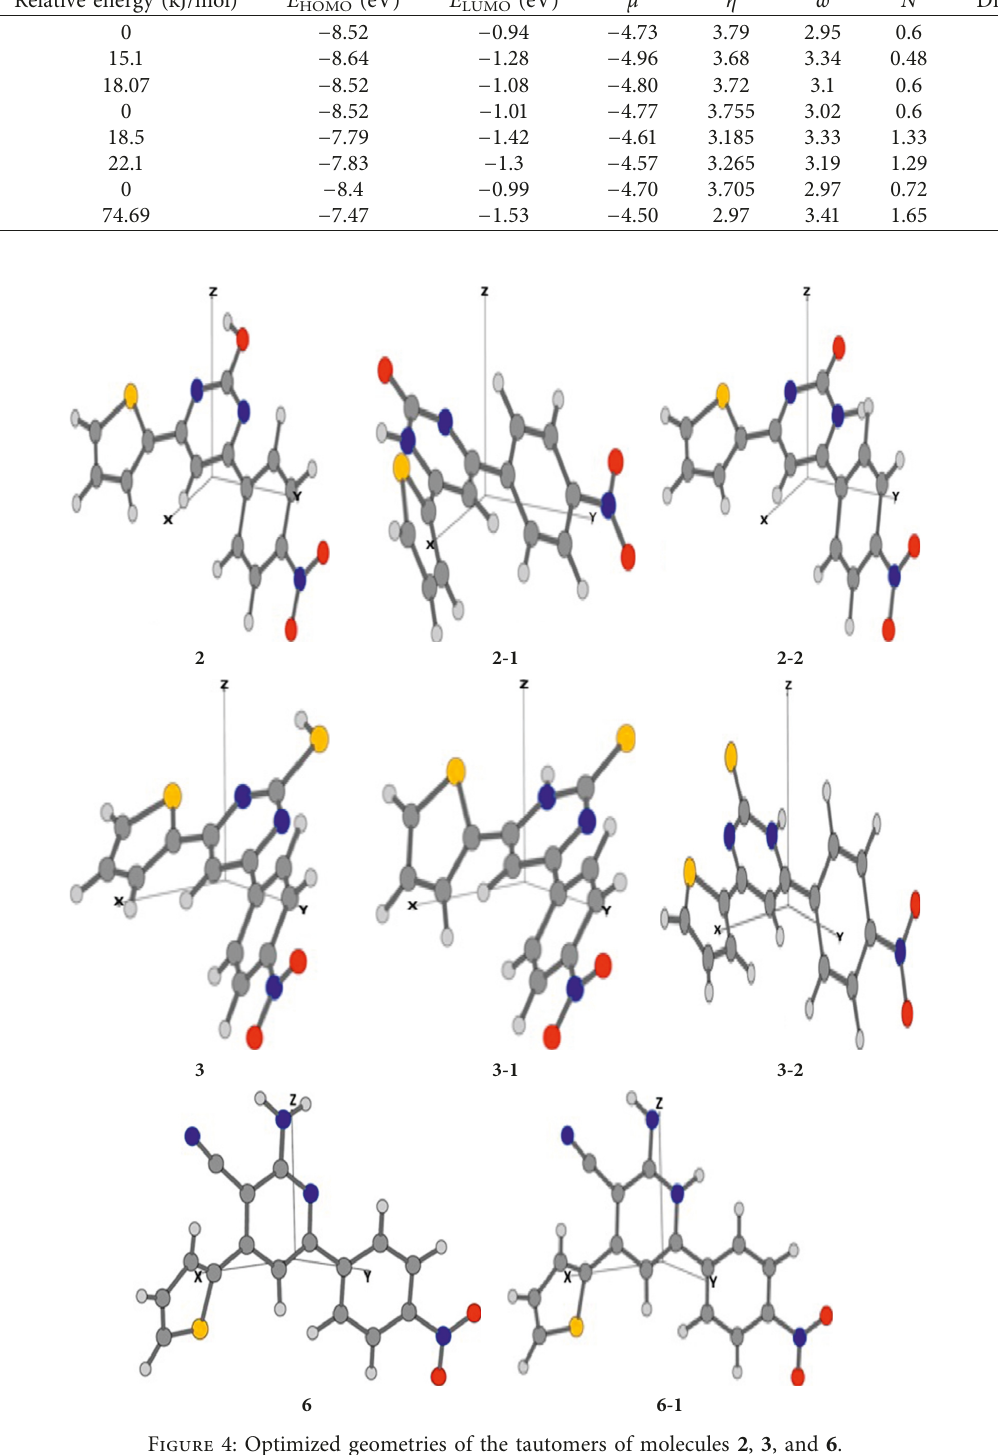
Table 3: Relative energies and frontier orbital energies of the tautomers of molecules 2 (denoted as 2-1 and 2-2), 3 (3-1 and 3-2), and 6 (6-1) in the gas phase.